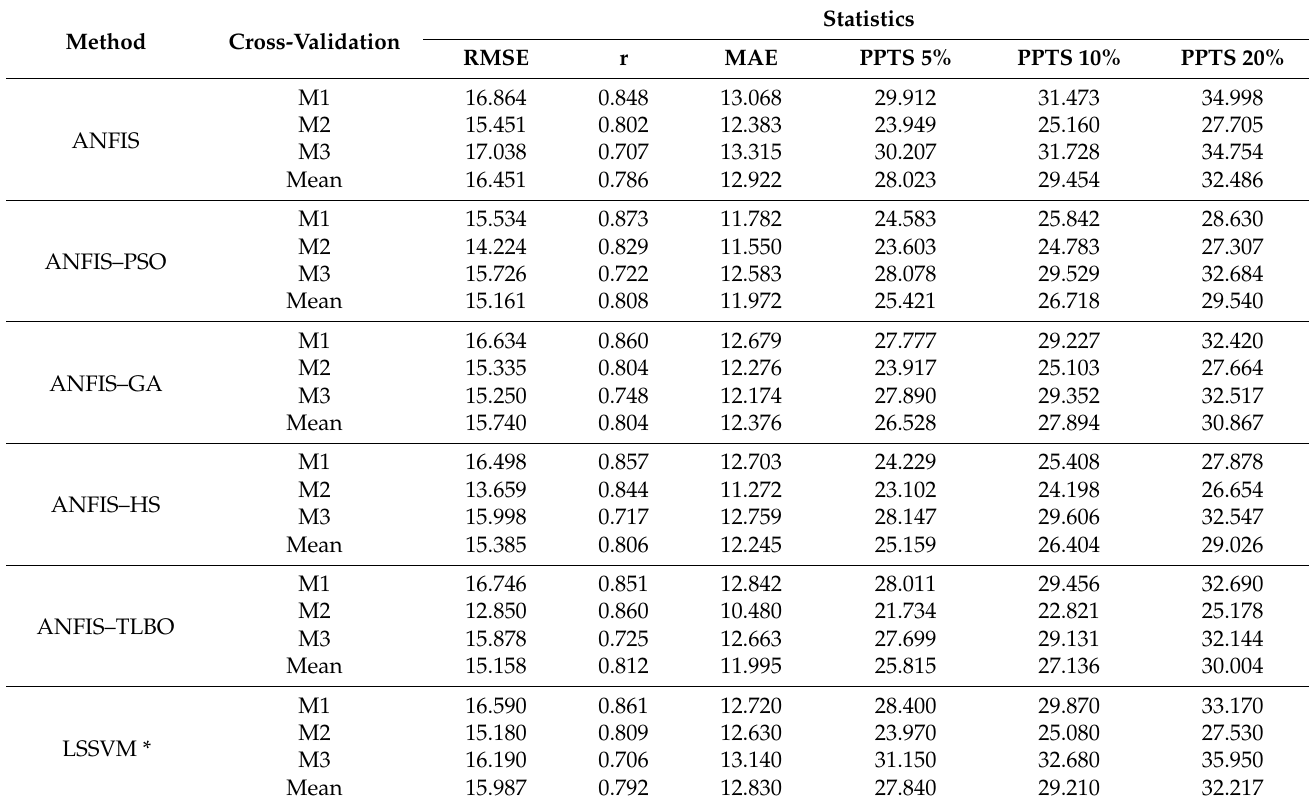
Table 8. Comparison of the models’ performance with all variables as inputs.